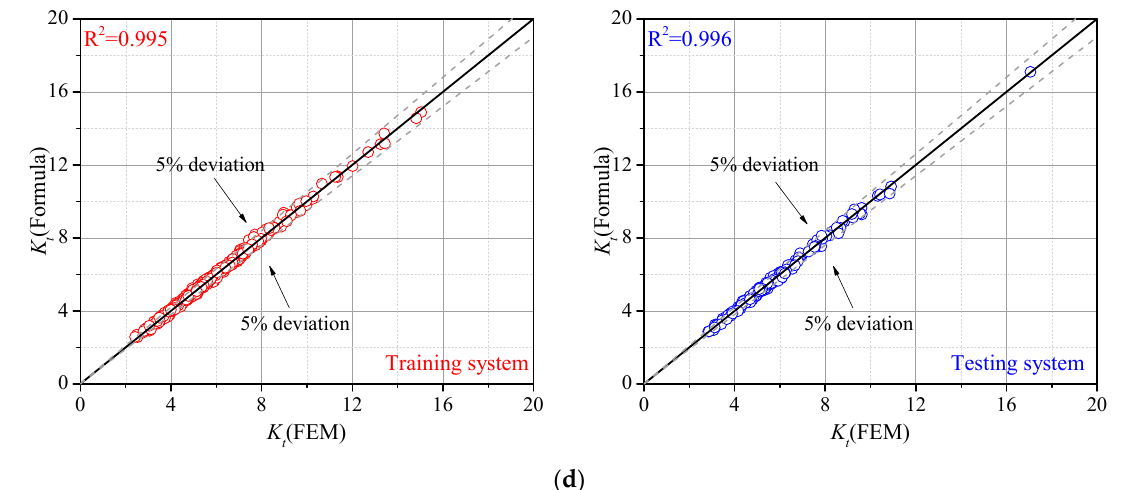
Figure 7. Comparison of stress concentration factors (SCFs determined by FE analysis and proposed parametric formulae: ( a ) Gusset welded joint with single attachment under tensile stress; ( b ) Gusset welded joint with single attachment under bending stress; ( c ) Gusset welded joint with double attachments under tensile stress; ( d ) Gusset welded joint with double attachments under bending stress.